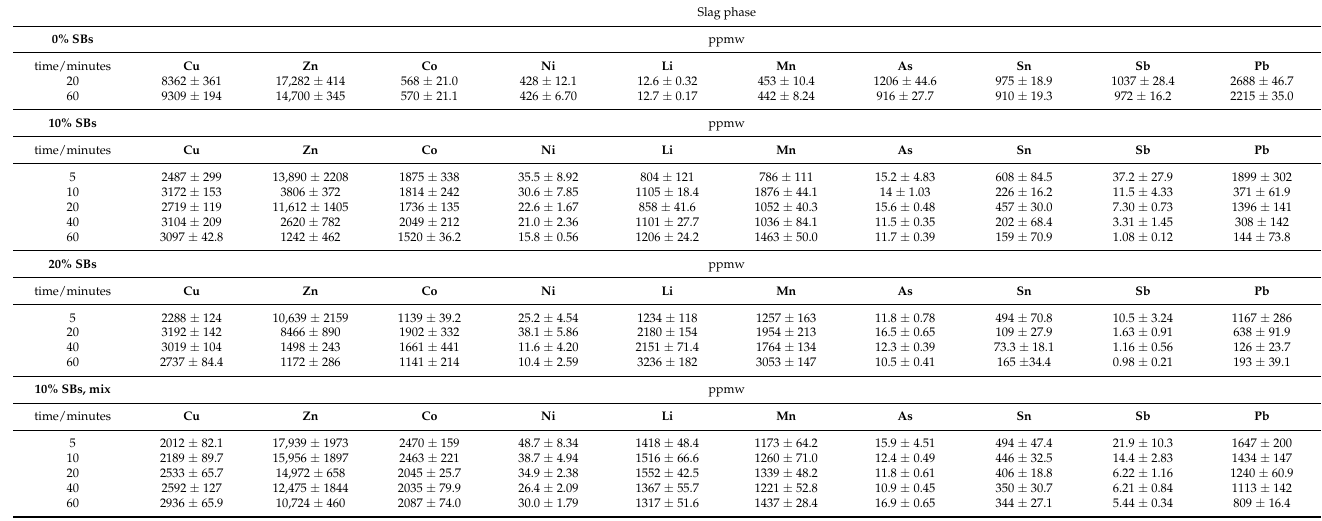
Table A1. Chemical concentration of trace elements in the slag phase analyzed with LA-ICP-MS.